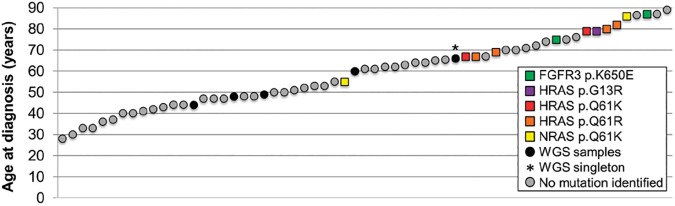
Mutation status of SpTs in relation to age at diagnosis.Age at presentation of 61 SpT samples that were screened for hotspot mutations in genes associated with selfish spermatogonial selection in this and in previous studies [17, 18]. Mutational status indicated by color chart on the Figure. In this study, out of the 29 FFPE samples screened (S1 Table), NRAS p.Q61R mutations were identified in two cases (aged 55 and 86 years); the other mutation-positive cases were previously documented in [17, 18].